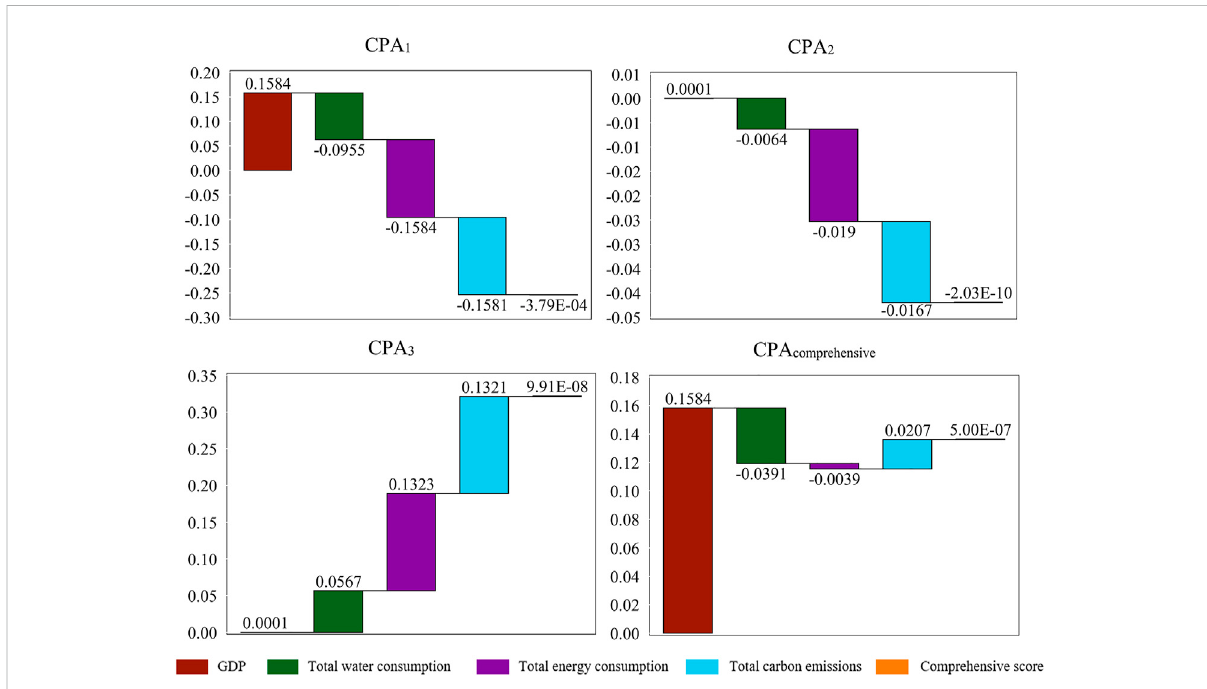
FIGURE 8 Annual average change rate and comprehensive score under different scenarios (Waterfall diagram adopts the combination of absolute value and relative value, which can not only re fl ect the amount of data, but also intuitively re fl ect the change process of data increase or decrease. The annual average change rate represents the increase or decrease rate of GDP, energy consumption, water consumption and carbon emission under differentscenariosfrom2022to2030.Itnotonlyshowsanupward(downward)trend,butalsoindicatestheamountofincrease(decrease).The higher the comprehensive score is, the more coordinated of the economic development, resource consumption reduction and carbon emission of the city